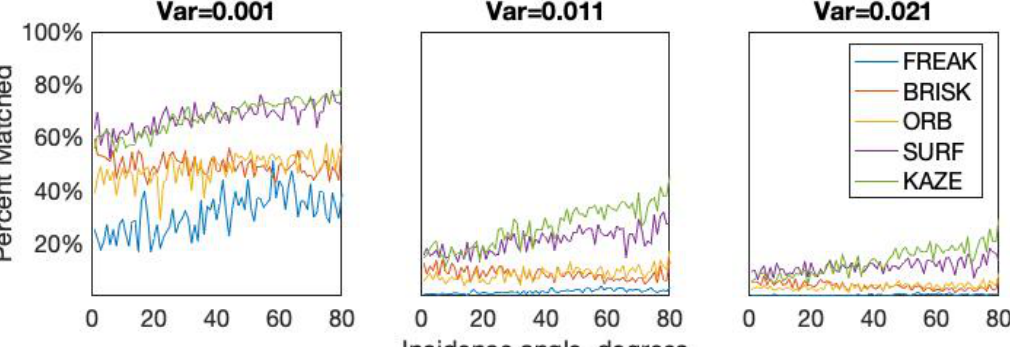
Figure 9. Performance of feature descriptors when Gaussian noise is applied to image with a mean of zero and a variance of 0.001, 0.011, and